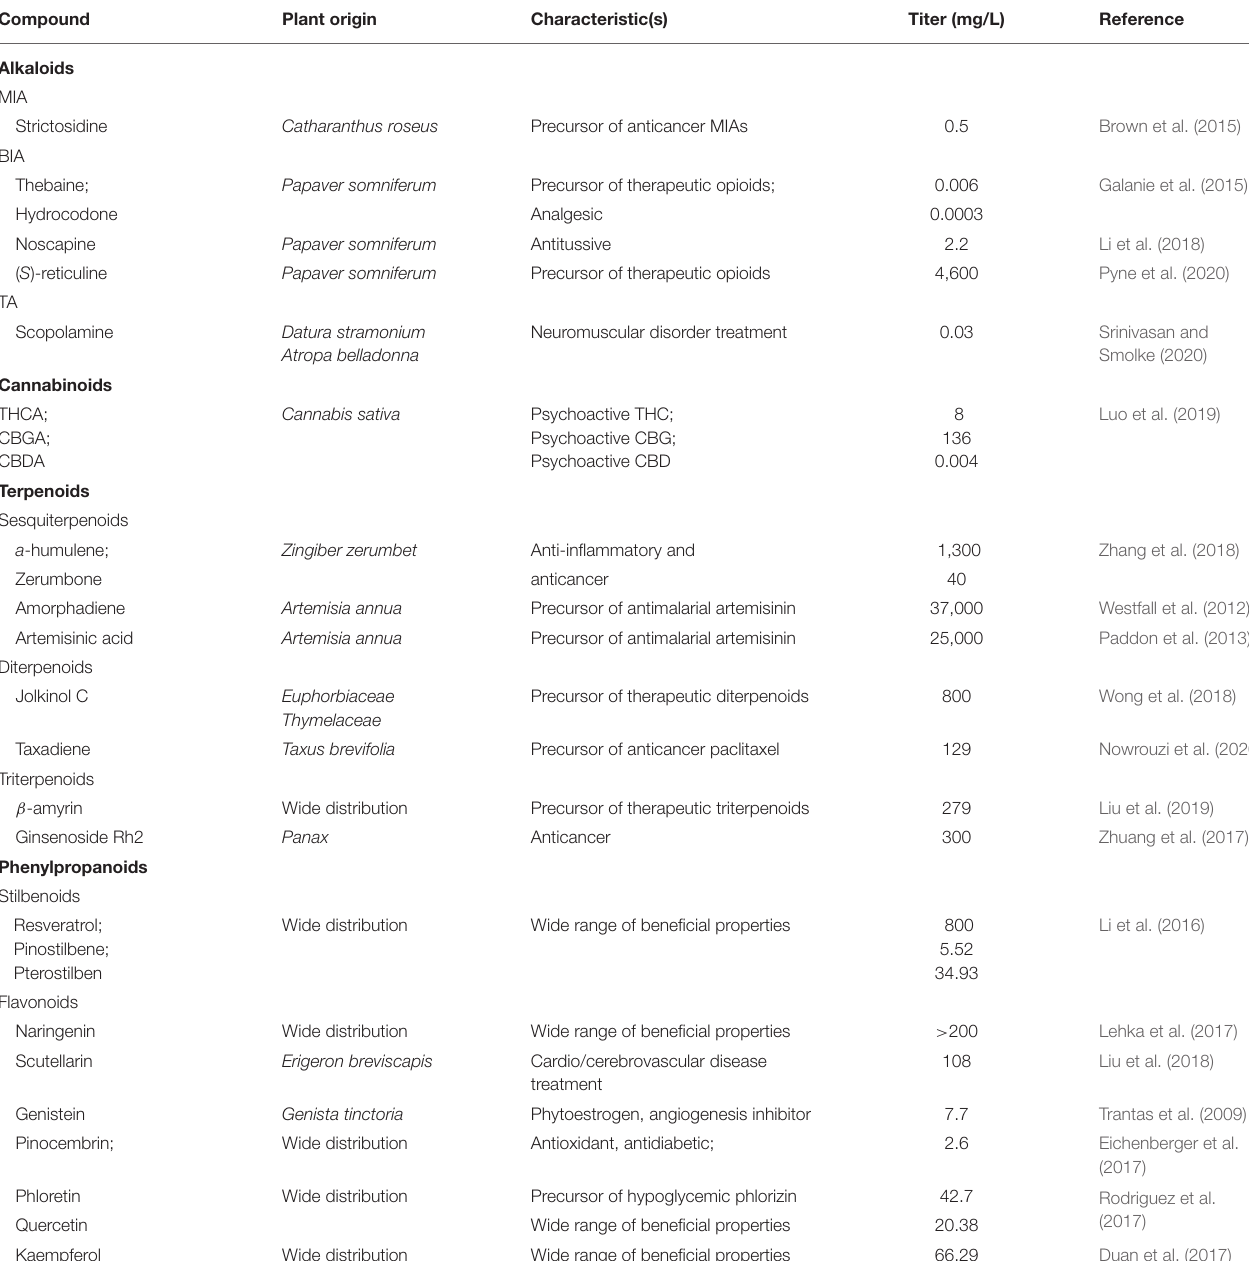
TABLE 2 | Plant-derived therapeutic NPs produced in S. cerevisiae (adapted and updated from Pyne et al.,